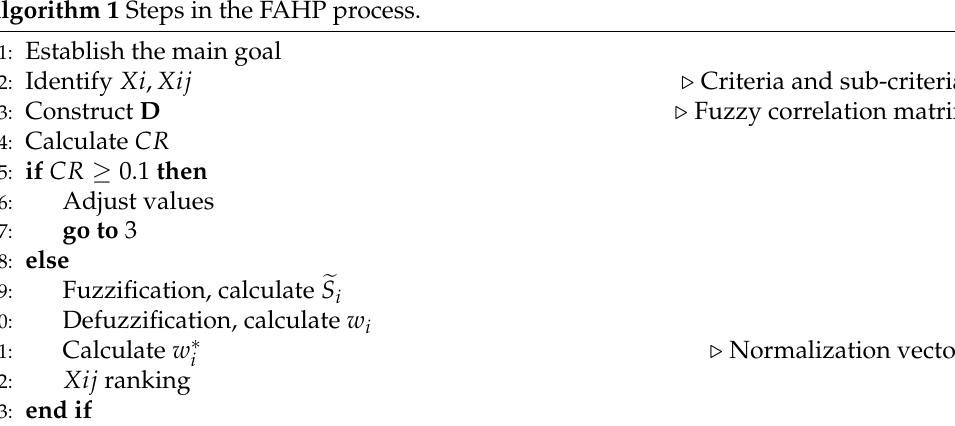
Algorithm 1 Steps in the FAHP